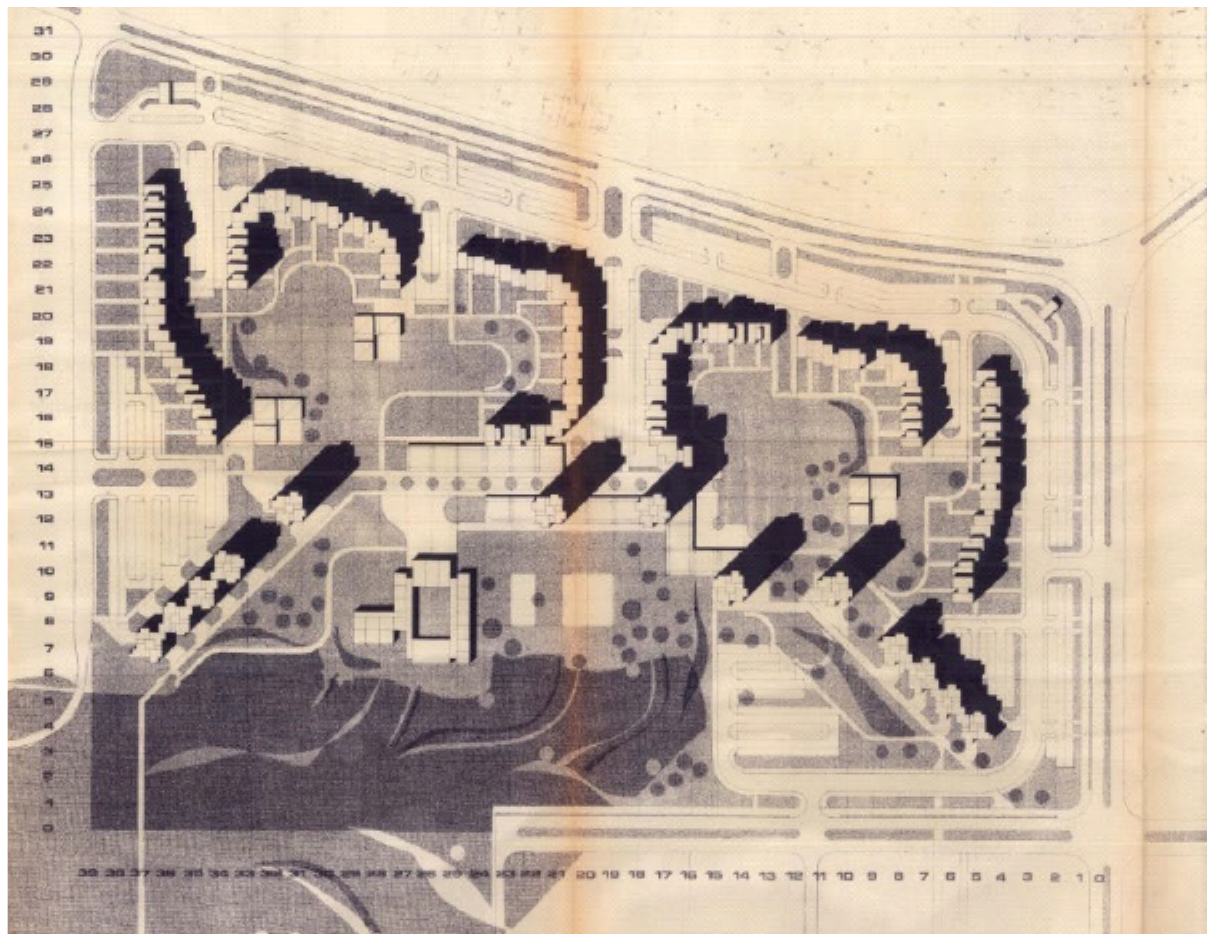
Fig. 11 Detailed urbanist plan for Blok 5 by Vukota Tupa Vukotić, 1976. (Source: Milica Vujošević, Jelena Rabrenović, Sonja Dragović (eds.), Pristup izradi planskog dokumenta: Učešće javnosti u planiranju Bloka 5 u Podgorici , 2017,